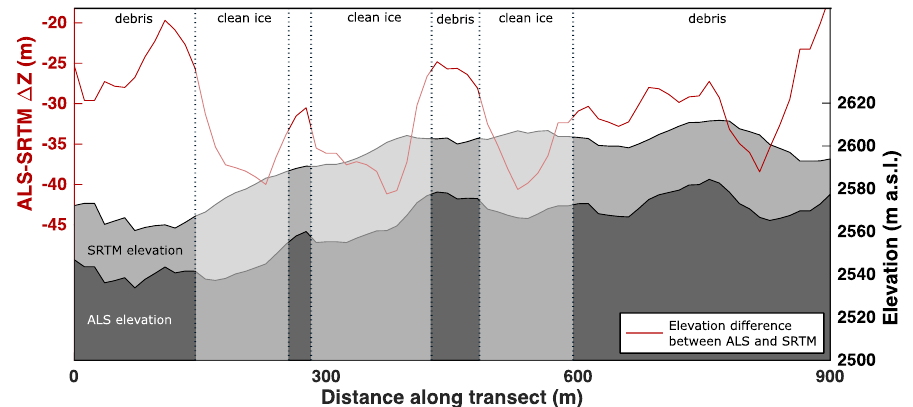
Figure 8. Cross-sectional profile of the Universidad Glacier surface elevation in 2000 and 2013 (see profile location in Figure